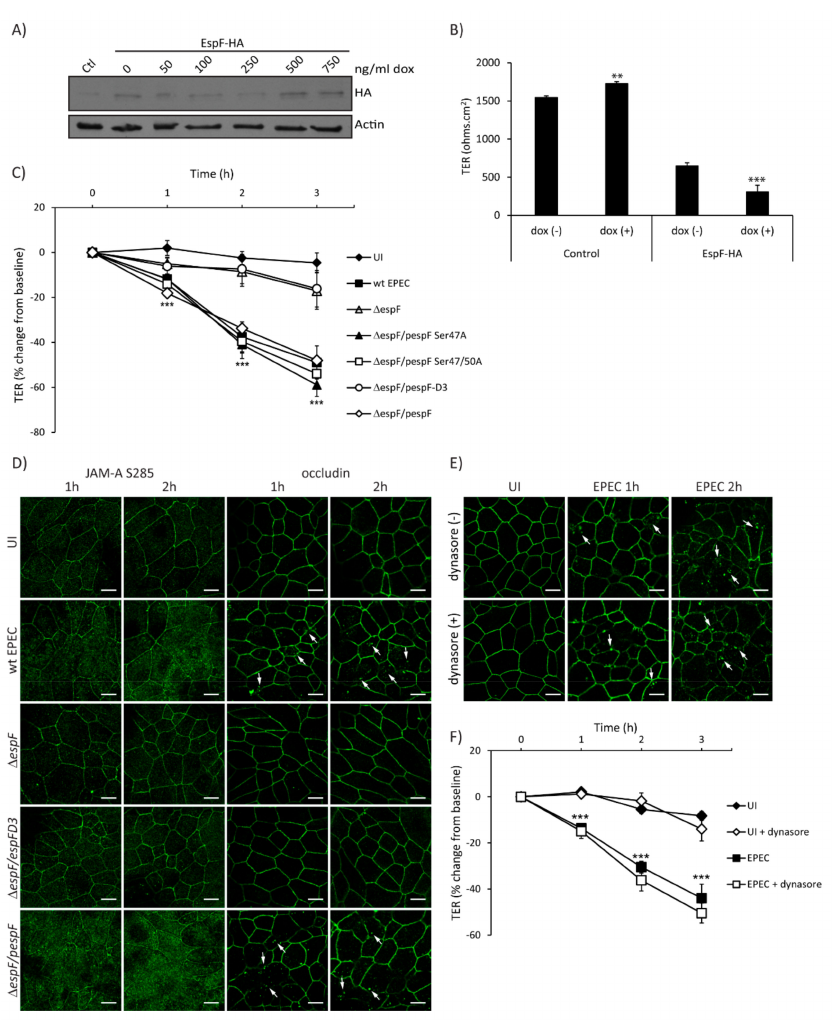
Figure 4. The SNX9 binding domain of EspF is crucial for disruption of TJ structure and function. ( A and B )TogenerateTet–Oncells,EspF–HAwasclonedintothedoxycycline-induciblep–RetroX–Tight–Pur vector and transfected or not (control – Ctl) into wild-type SKCO-15 cells. Tet–On SKCO-15 cells were plated in absence of doxycycline (dox). ( A ) EspF–HA expression was induced with increasing concentrations of dox for three days. Cells were processed for western blot and detection of HA was performed. ( B ) Tet–On SKCO-15cellswereculturedonTranswellsfor1week(-dox)thenexpressionofpRetroX–Tight–Pur–EspF-HA was induced ( + dox) for three days. Basal expression of EspF–HA induces a significant reduction in TER (-dox) as compared to controls. Induction of EspF–HA ( + dox) significantly reduces TER even further. ( C and D ) SKCO-15 monolayers were infected with wt EPEC, ∆ espF , or ∆ espF complemented with wt espF or site-directed espF mutants ( ∆ espF / pespF , ∆ espF / pespF D3, ∆ espF / pSer47A , or ∆ espF / pSer47 / 50A ). TER and localization of JAM-A S285 and occludin were determined. ( C ) Infection with ∆ espF / pespF, ∆ espF / pSer47A and ∆ espF / pSer47 / 50A mutant strains reduce TER to levels similar to those induced by wt EPEC infection. Infection with ∆ espF or ∆ espF / pespF D3 significantly blunt the decrease in TER compared to wt EPEC. *** p < 0.001. ( D ) Infection with wt EPEC and ∆ espF / pespF redistributes JAM-A S285 and occludin from intercellular junctions to the cytoplasm. Infection with ∆ espF or ∆ espF / pespFD3 does not alter the localization of JAM-A S285 and occludin. Scale bar, 10 µ m. ( E and F ) SKCO-15 monolayers were treated with or without dynasore 1 h prior to EPEC infection, then occludin localization and TER were assessed. ( E ) Blocking dynamin-dependent endocytosis with dynasore fails to prevent occludin internalization induced by wt EPEC infection. Arrows indicate the endocytosis of occludin triggered by EPEC infection. Scale bar, 10 µ m. ( F ) Dynasore does not prevent the drop in TER induced by EPEC. TER reported as percent change from baseline. * p < 0.01, *** p <